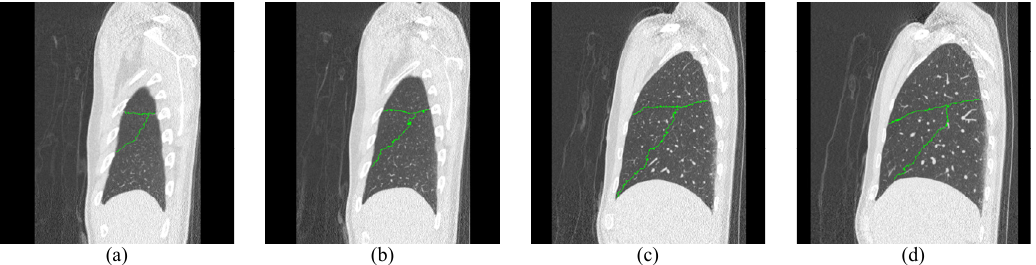
Figure 12. The second experimental result for the right lung CT by the proposed ACO framework.